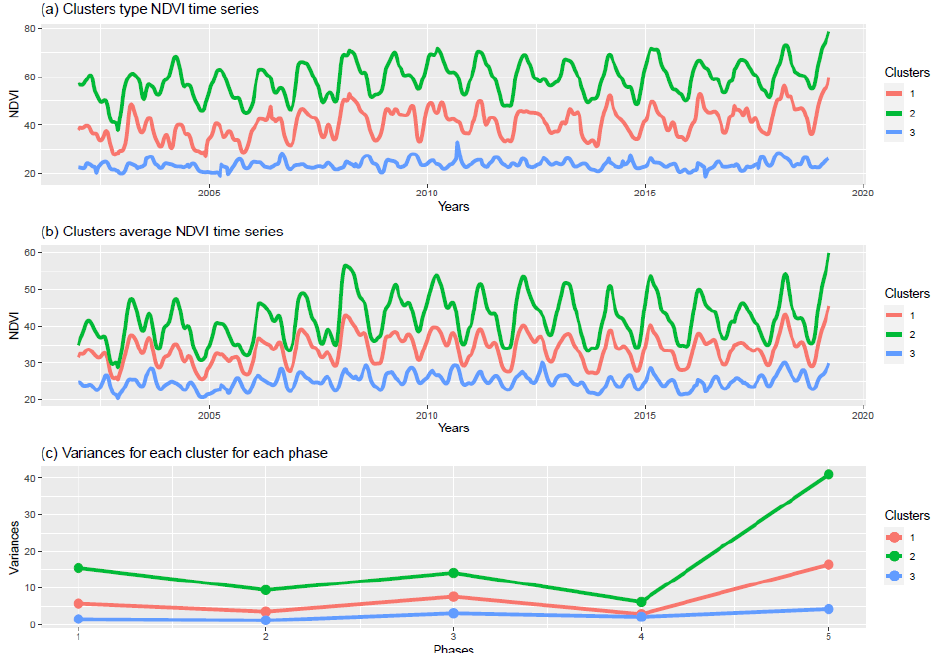
Figure 10. Time series of cluster prototypical pixels in: ( a ) the cluster type (selected based on their vegetation type: mixed shrubland for cluster 1, open woodland for cluster 2 and grassland for cluster 3); ( b ) the average of each cluster; and ( c ) the variances for each cluster and phase, based on the NDVI dynamics following [64].